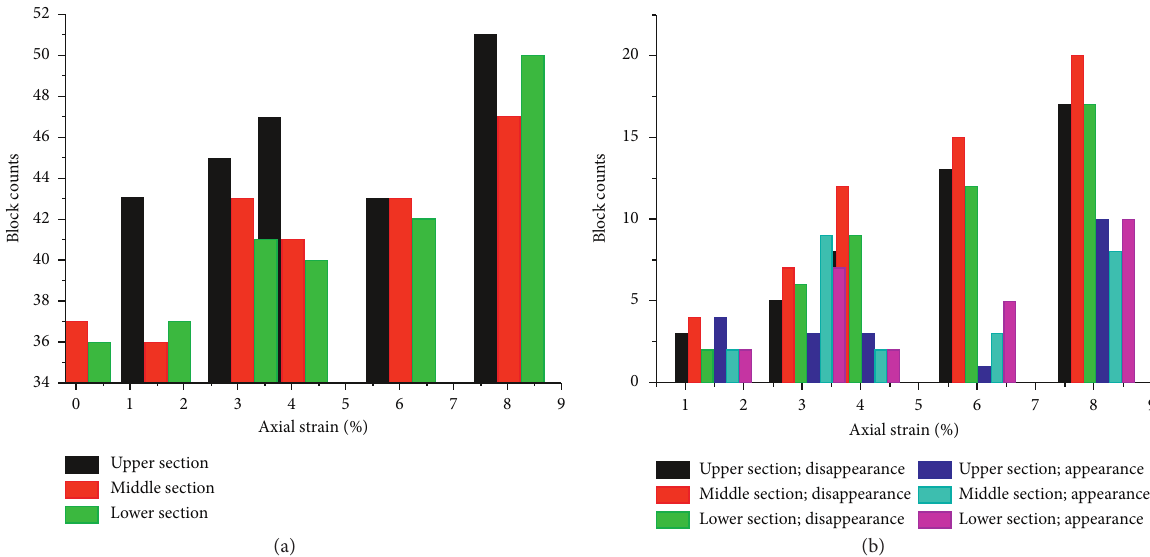
Figure 8: Statistical number of rock blocks in bimrock under deformation for the three scanned sections. (a) Total number of rock blocks at different axial strains; (b) number change of rock block at different axial